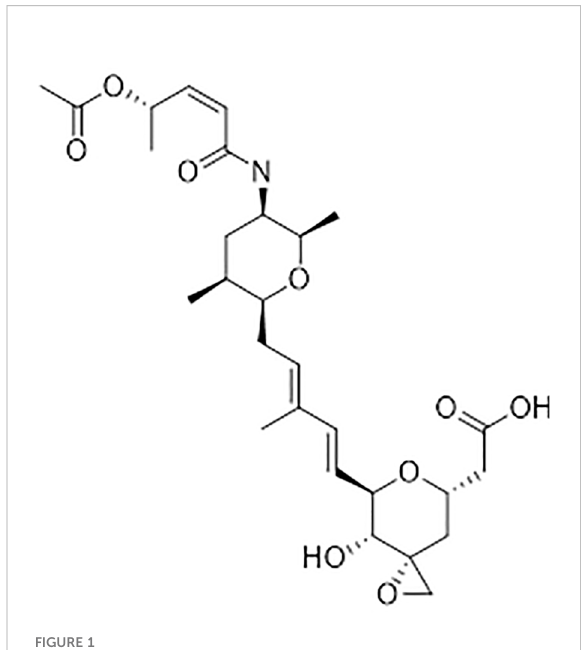
FIGURE 1 Chemical structure of Splicing inhibitor: spliceostatin